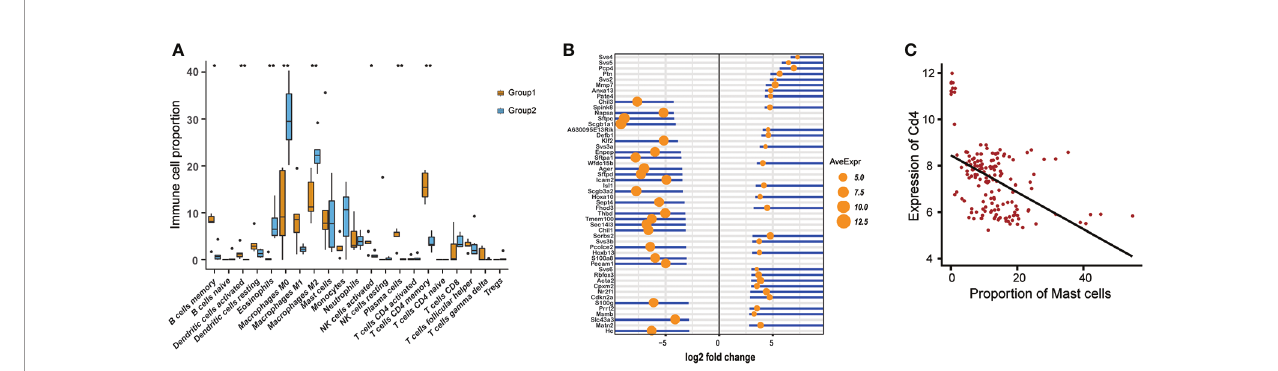
FIGURE 3 | Results from the analysis modules in ImmuCellDB. (A) The variation of immune cell abundances between two groups returned by ImmDiff tool. A comparison for the proportional difference of each immune cell between the two groups was conducted with a t-test and the P-value was used to interpret the difference (**indicates the P-value < 0.01, * means 0.01 < P-value < 0.05). (B) Confects plot for the differentially expressed genes between two conditions by ExpresDiff tool. The area of the dot was proportional to the averaged gene expression value and the length of the line was negative correlated with the log2 fold change. (C) Dot plot for the correlation between the immune cell abundance and gene expression by Correlation tool. The glm method in geom_smooth function of “ ggplot2 ” package was used to fi tting for data